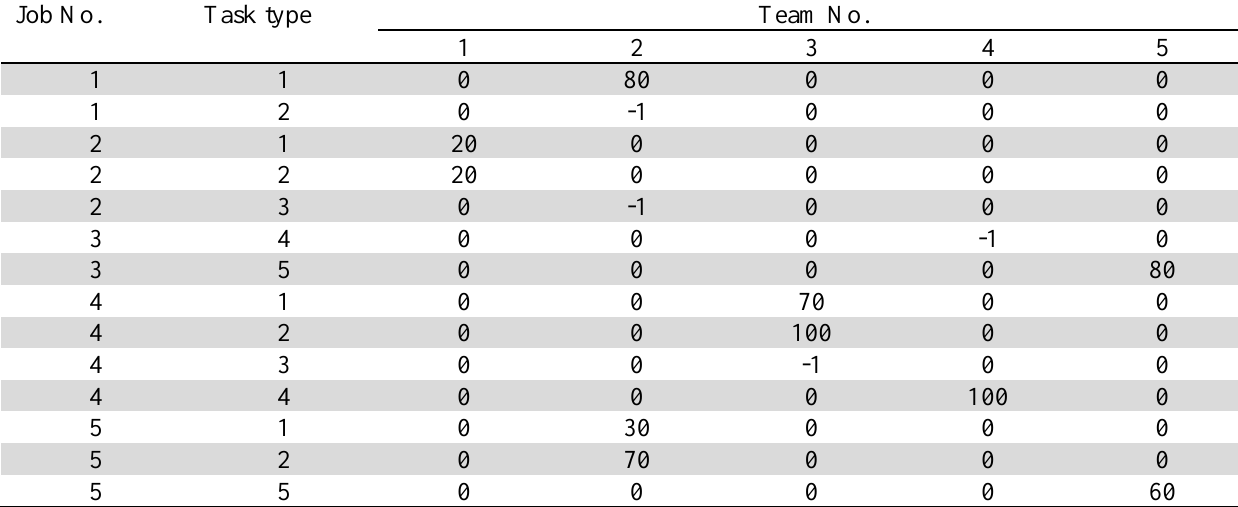
Fulfillment of started jobs at planning moment in % Job No.